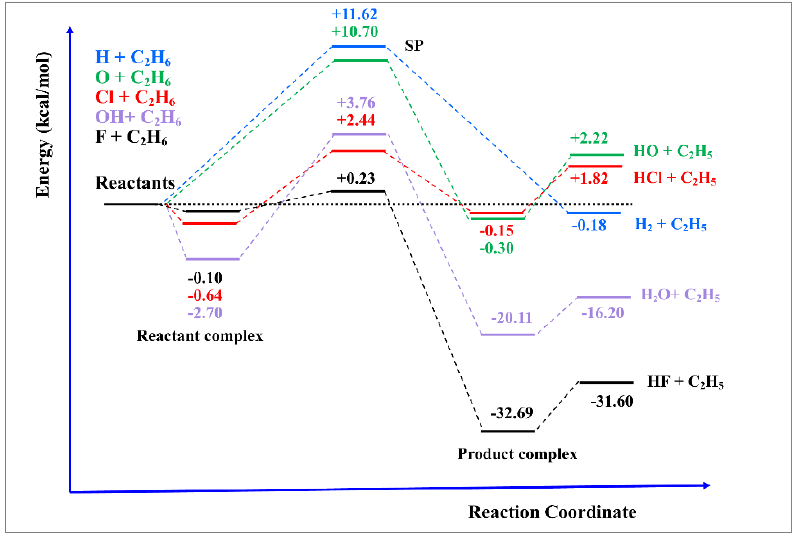
Figure 5. Schematic classical energy diagrams for the different bimolecular hydrogen abstraction reactions analysed in the present review. Theoretical results were obtained from our research group (see text).